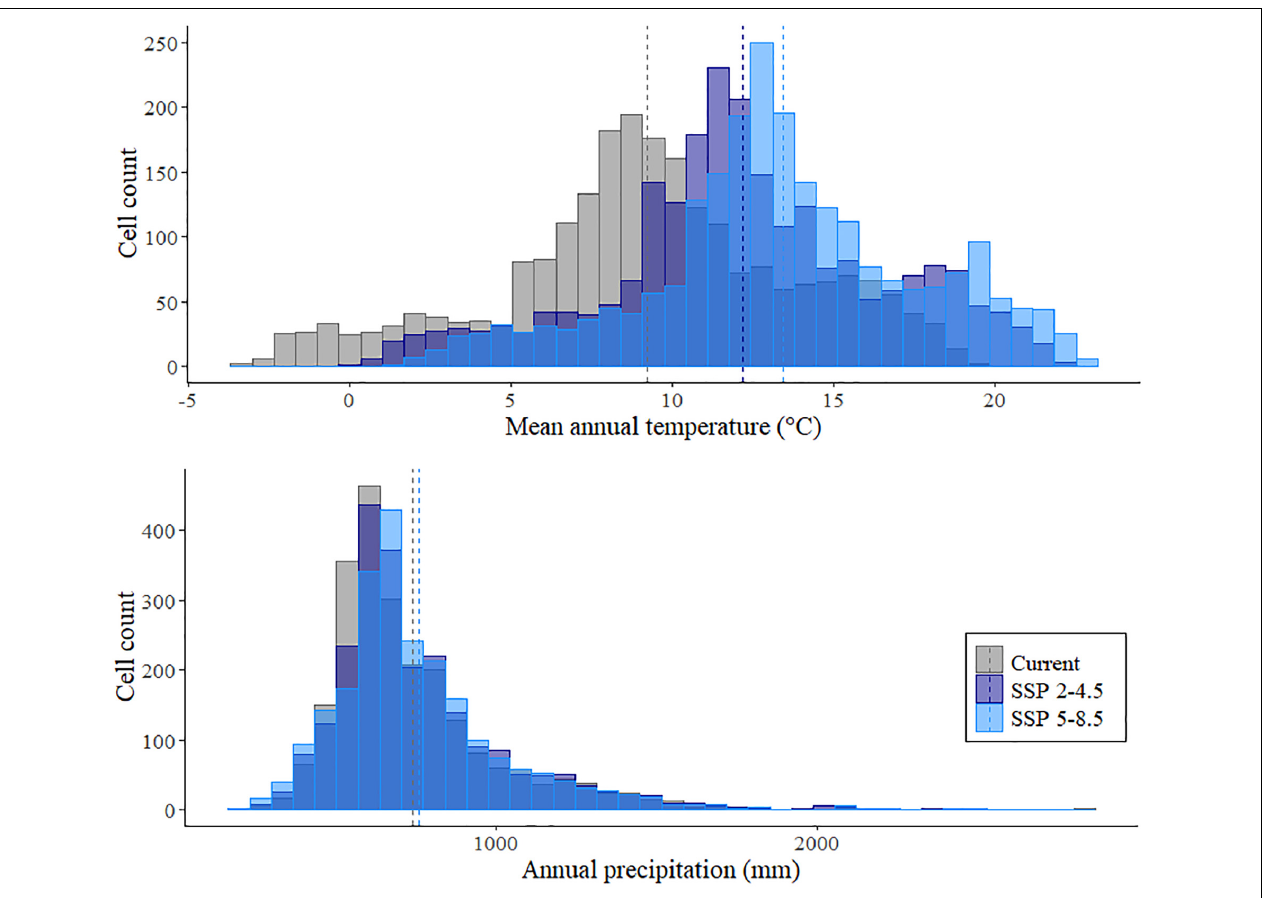
FIGURE 1 | Distribution of mean annual temperature and annual precipitation in Europe predicted for the current climate, and projected to occur in the years 2061–2080 under two Shared Socio-economic Pathways (SSP2-4.5 and SSP5-8.5). Bars represent the number of 50 km grid squares of Europe with a corresponding mean temperature or precipitation value, and dotted lines represent the mean values.